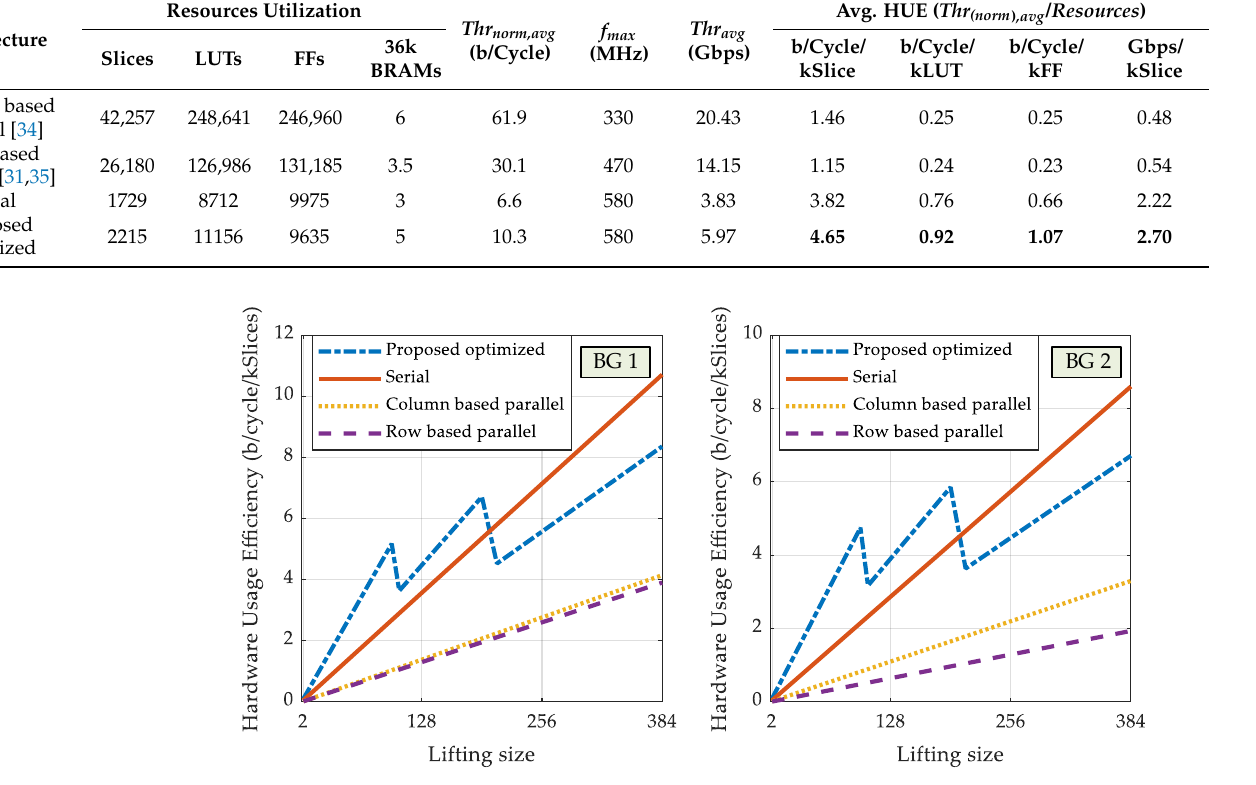
Figure 14. Normalized hardware usage efficiency for various 5G NR LDPC encoder architectures depending on the lifting size.